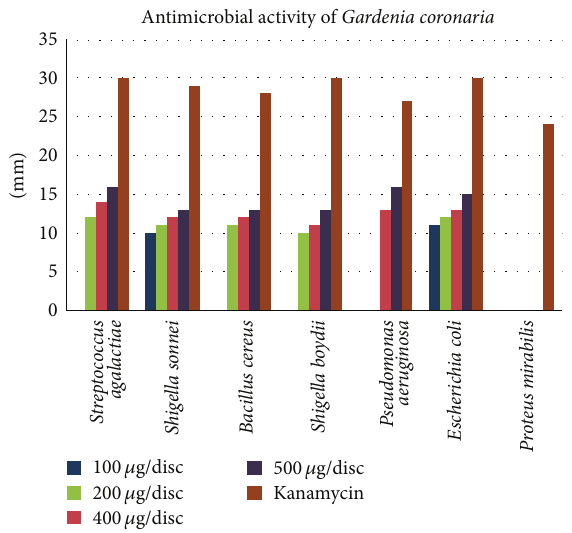
Figure 1: Graphical representation of difference in zone of inhi- bition of different bacteria in different extract concentrations of Gardenia coronaria leaves along with the standard Kanamycin.